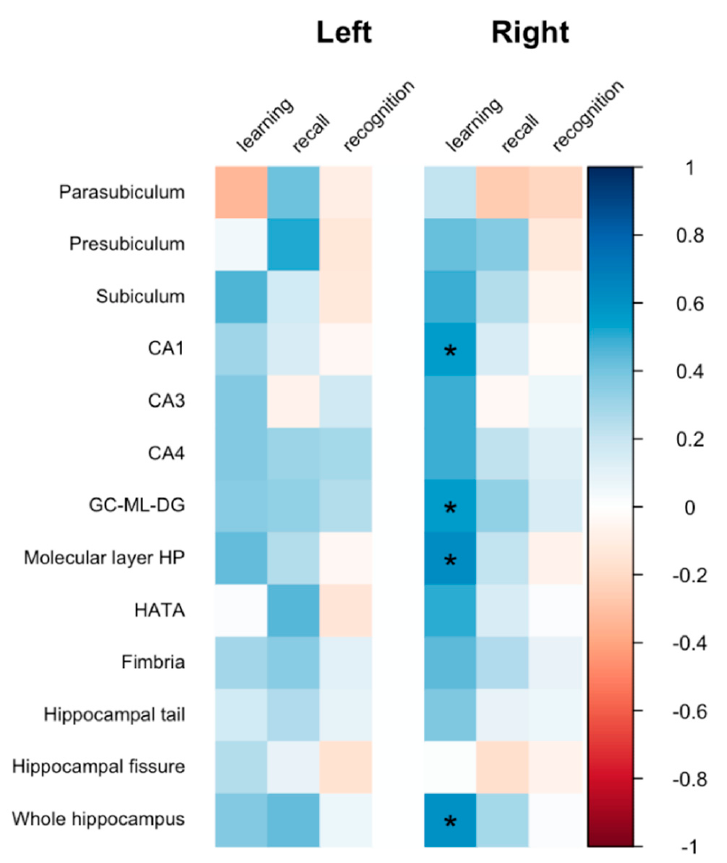
Figure 3. Correlation between hippocampal subfield volume and memory score.* p < 0.05 after correction for multiple comparisons using the false-discovery rate. The color scale bar represents the Pearson’s correlation coefficient. CA: cornus ammonis, GC-ML-DG: granule cell and molecular layer of the dentate gyrus, HATA: